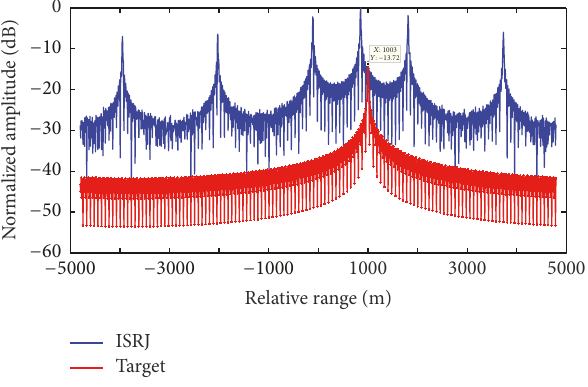
Figure 4: The compression result before ECCM ( 𝑇 𝑠 = 2 𝜇 s).